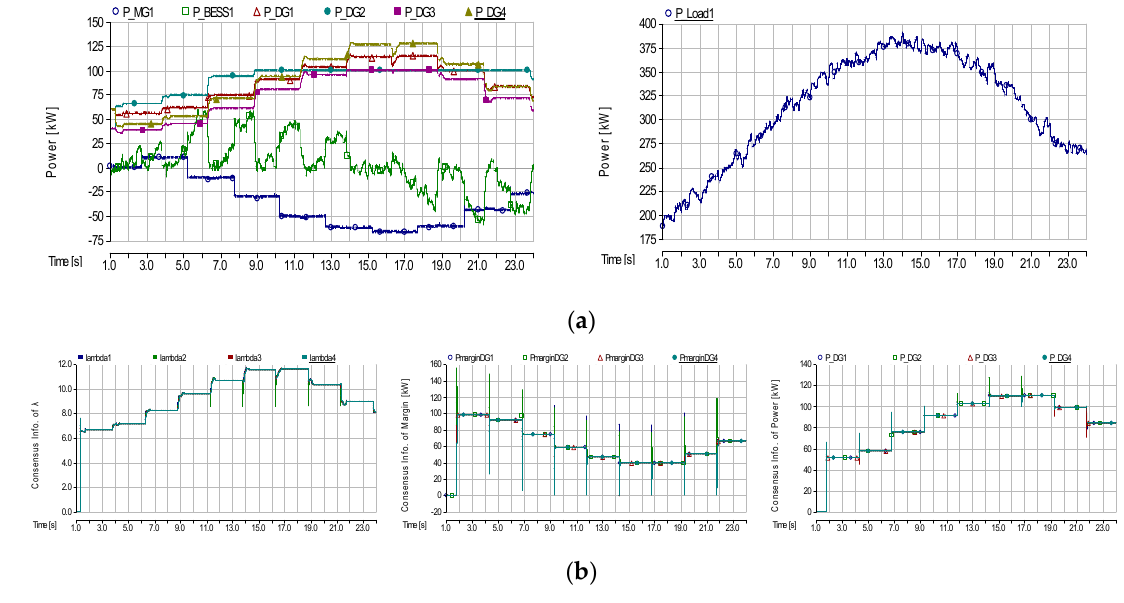
Figure 10. Simulation result in the MG level (Case 3). ( a ) Power of the MG flow, the MG BESS, the DGs, and load in the MG1; ( b ) Convergence of the incremental cost, the power margin, and the current power of the DGs in the MG1.